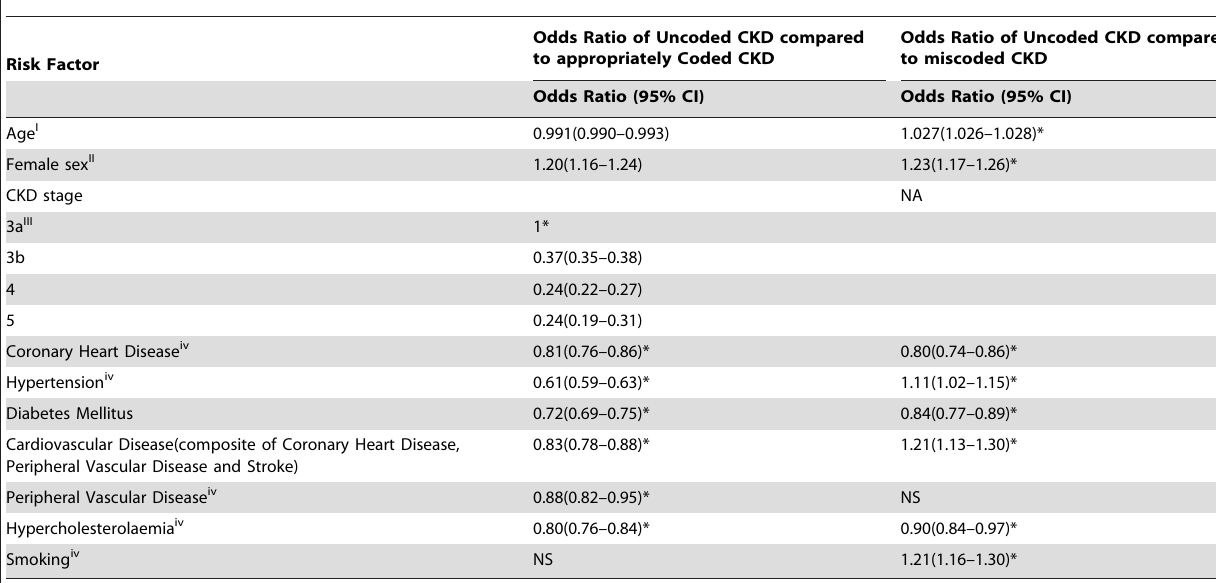
Table 2. Multivariate Logistic Regression Model for significant predictors for inclusion on CKD QOF